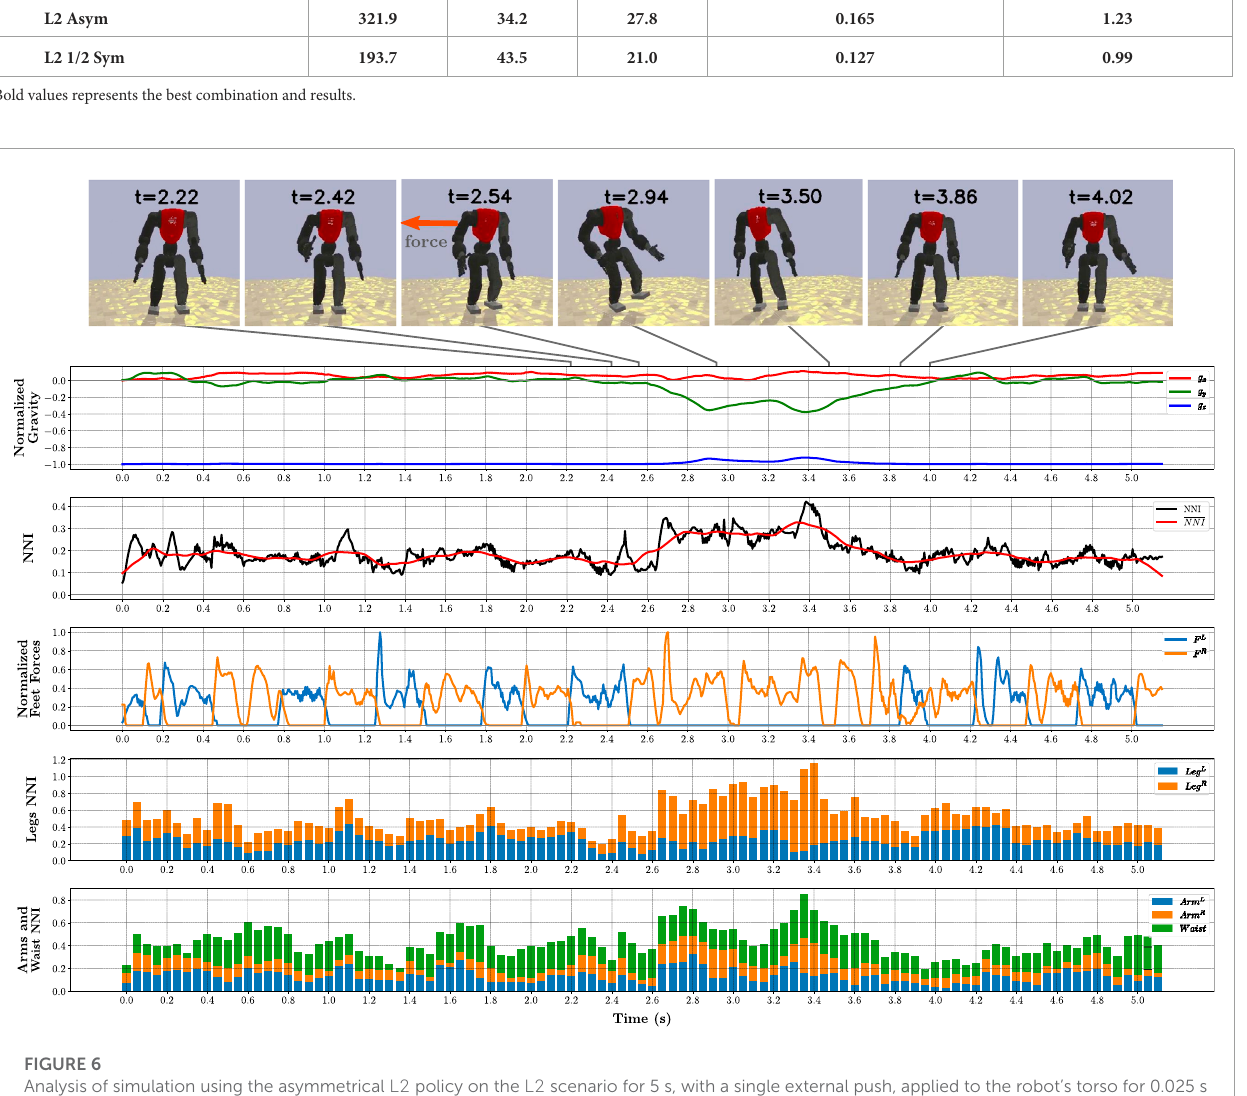
(Evans et al.,2012).However,humansarenotperfectlysymmetrical, and unbalanced gait patterns can be perceived as unimpaired or normal, within reason (Handžić and Reed, 2015). Therefore, in the context of human-like behaviours, the symmetry of a policy should be leveraged, but not to the point where it becomes a hard constraint. In these simulations, the kernel pattern generator produces symmetrical trajectories upon which the neural network residuals are applied. To evaluate the residuals symmetry,